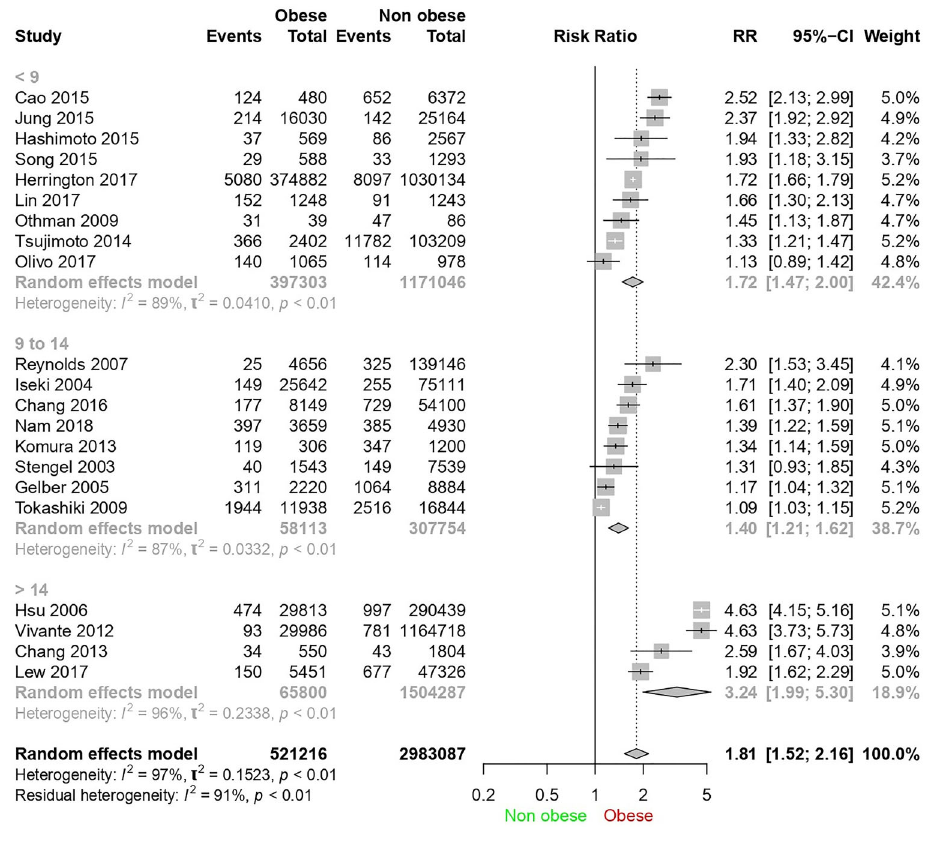
Figure 3. Forest plot for sensitivity analysis according to years of